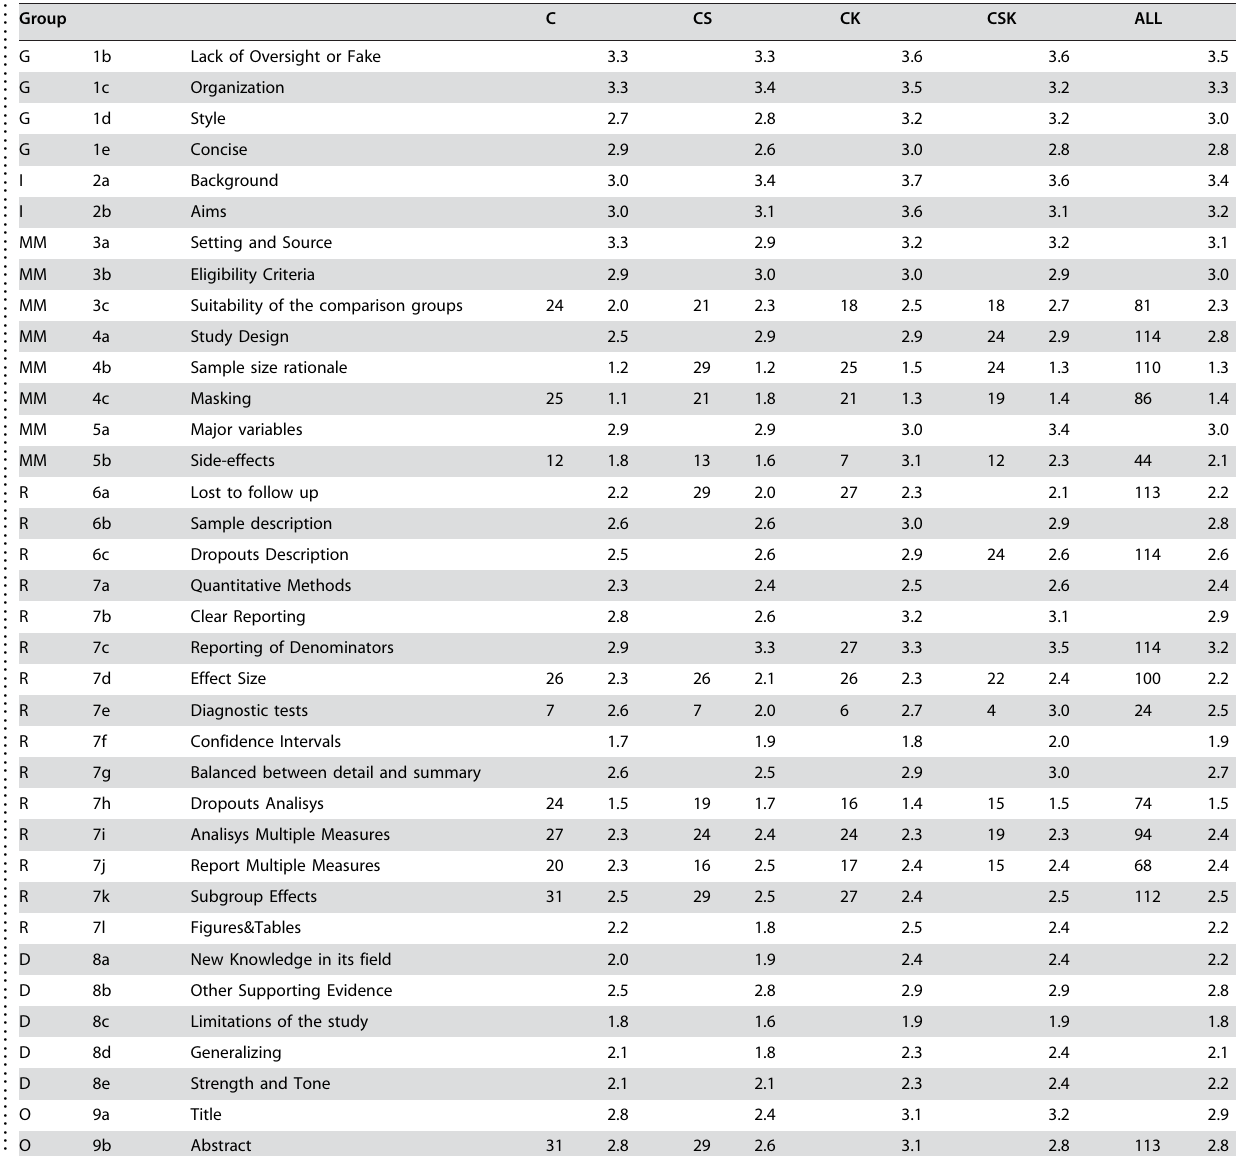
Table 3. Mean initial individual quality scores assessed by two blinded evaluators on the Goodman scale (lowest =1, highest= 5). Number of manuscripts is specified when that item did not apply to all manuscripts. Standard deviations ranged from 0.9 to 1.5. .. ... .... ... ... .... ... ... .... ... ... .... ... ... .... ... ... .... ... ... .... ... ... .... ... ... .... ... ... .... ... ... .... ... ... .... ... ... .... ... ... .... ... ...